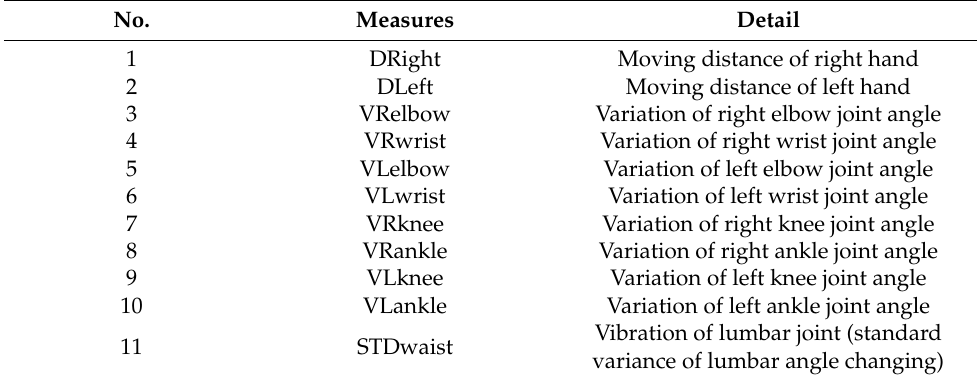
Table 2. Details of measures for analysis.